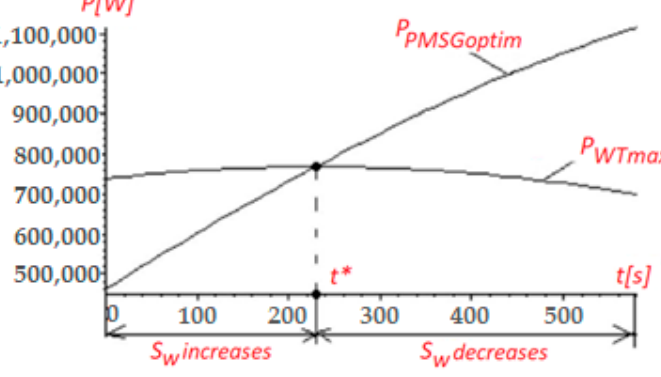
Figure 1. Time variations of the approximated wind speed, 𝑆 (cid:3050) (𝑡) , of its derivative, (cid:3031)(cid:3020) (cid:3298) ((cid:3047)) measured the wind speed, 𝑆 (cid:3050)(cid:3040)(cid:3032)(cid:3028)(cid:3046) (𝑡) .